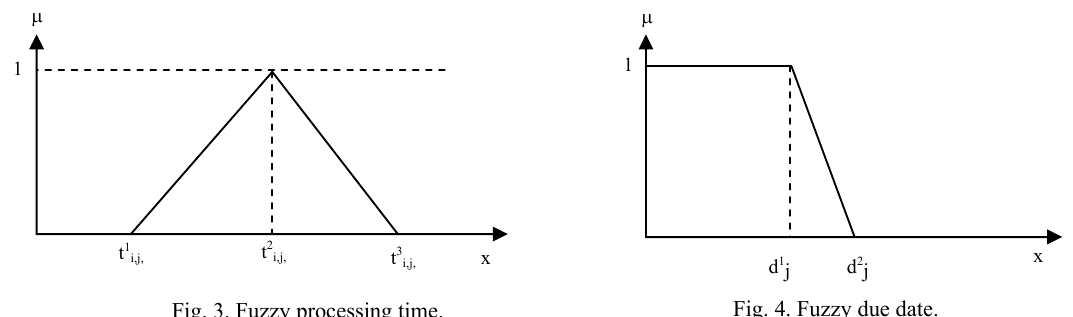
Fig. 3. Fuzzy processing time. Fig. 4. Fuzzy due